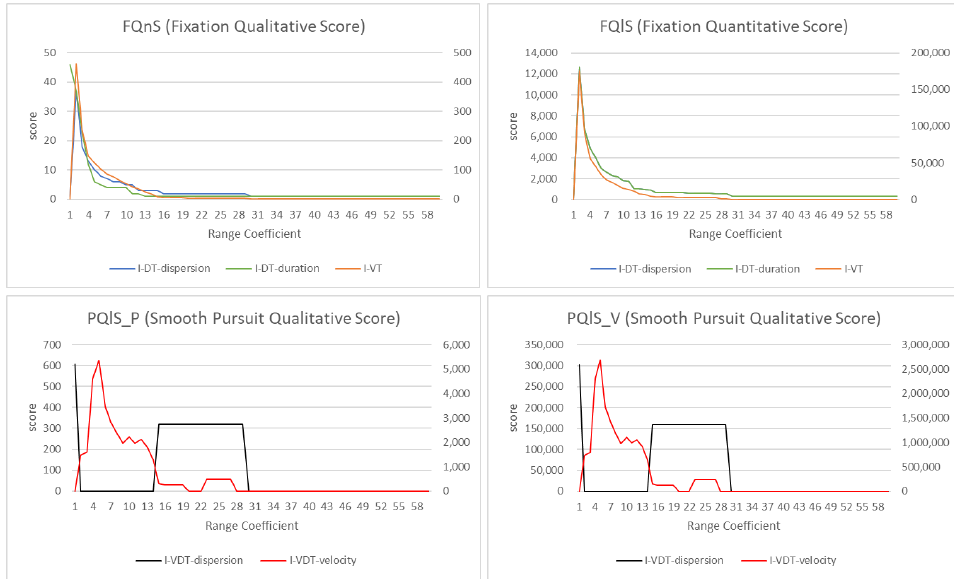
Figure 14. Qualitative and quantitative comparison of gaze-parsing algorithms requiring parameter setting. ( a ) The FQnS scores of I-VT and I-DT. ( b ) The FQlS scores of I-VT and I-DT. I-DT is divided into I-DT-dispersion and I-DT-duration in ( a , b ) because it has dispersion and duration threshold as parameters. ( c ) The PQlS_P scores of I-VDT. ( d ) The PQlS_V scores of I-VDT. In ( c , d ), since I- VDT has velocity and dispersion threshold as parameters, it is divided into I-VDT-velocity and